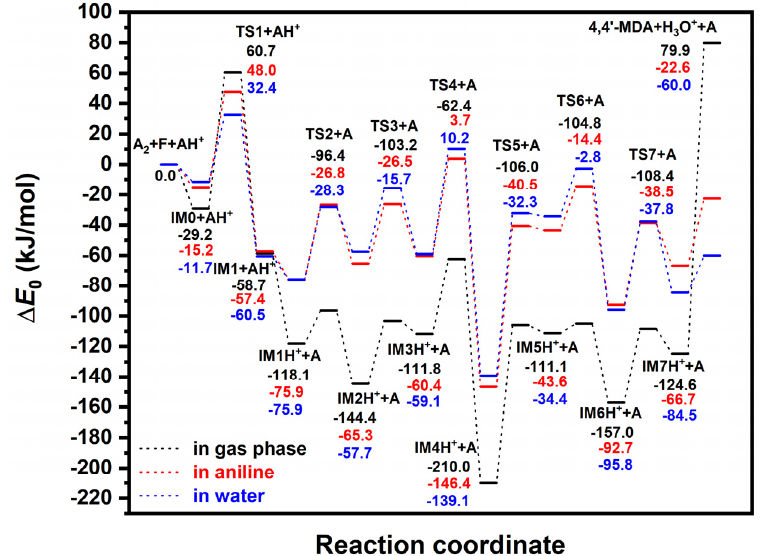
Figure 2. G3MPB3 energy profile (zero-point corrected) for MDA synthesis in gas phase (black), in aniline (red) and in water (blue).